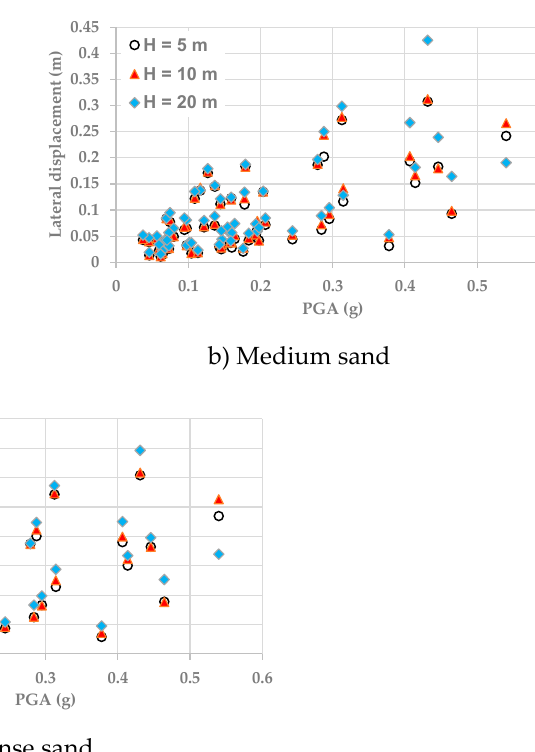
Figure 9. Effect of the PGA and the soil density on the lateral displacement of the building for the case of a liquefiable layer thickness of 20 m.